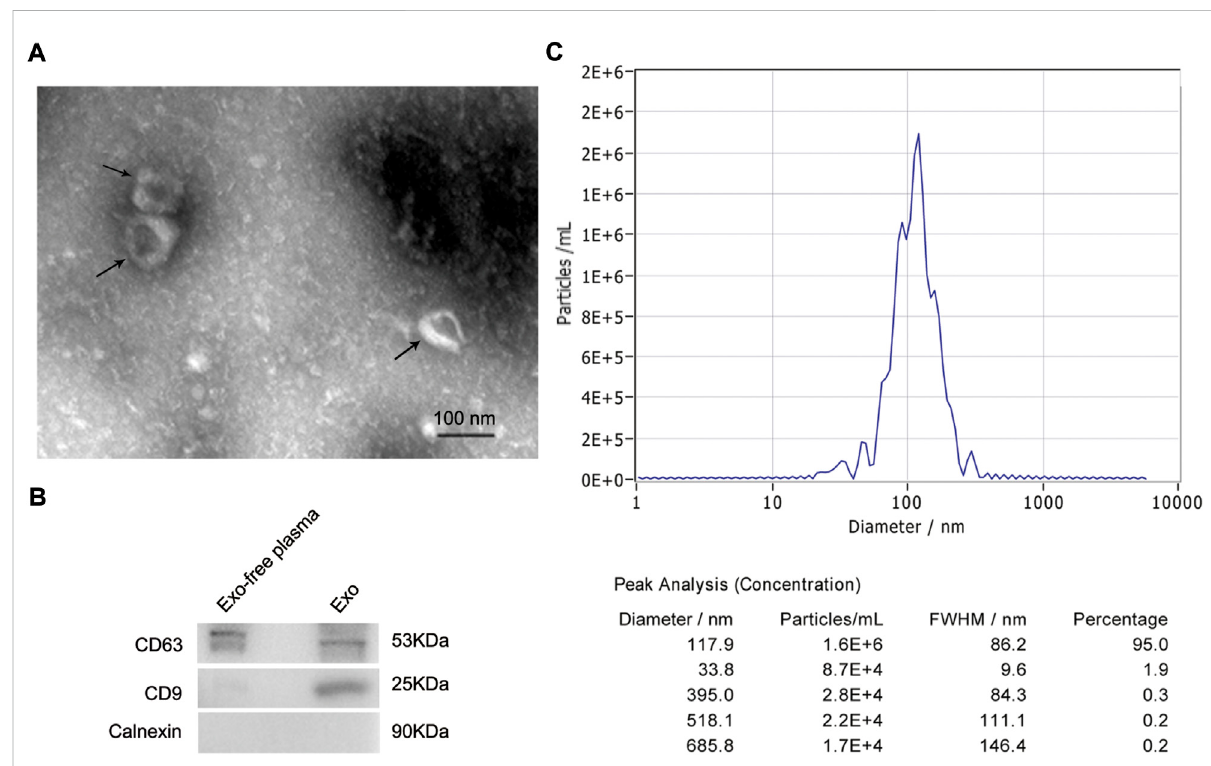
FIGURE 1 Identi fi cation of exosomes derived from plasma of HCC patients. (A) Representative TEM images of exosomes isolated from plasma of HCC patients. Black arrows indicating typical exosomes. Bar = 100 nm. (B) Exosome-enriched protein markers, including CD63 (53 kDa) and CD9 (25 kDa), and a negative marker, Calnexin (90 kDa), were analyzed by western blot. The exosome-depleted plasma was used as a control. (C) Size distribution of exosomes ranged from 50 to 150 nm as analyzed by nanoparticle tracking analysis. HCC, hepatocellular carcinoma; TEM, transmission electron